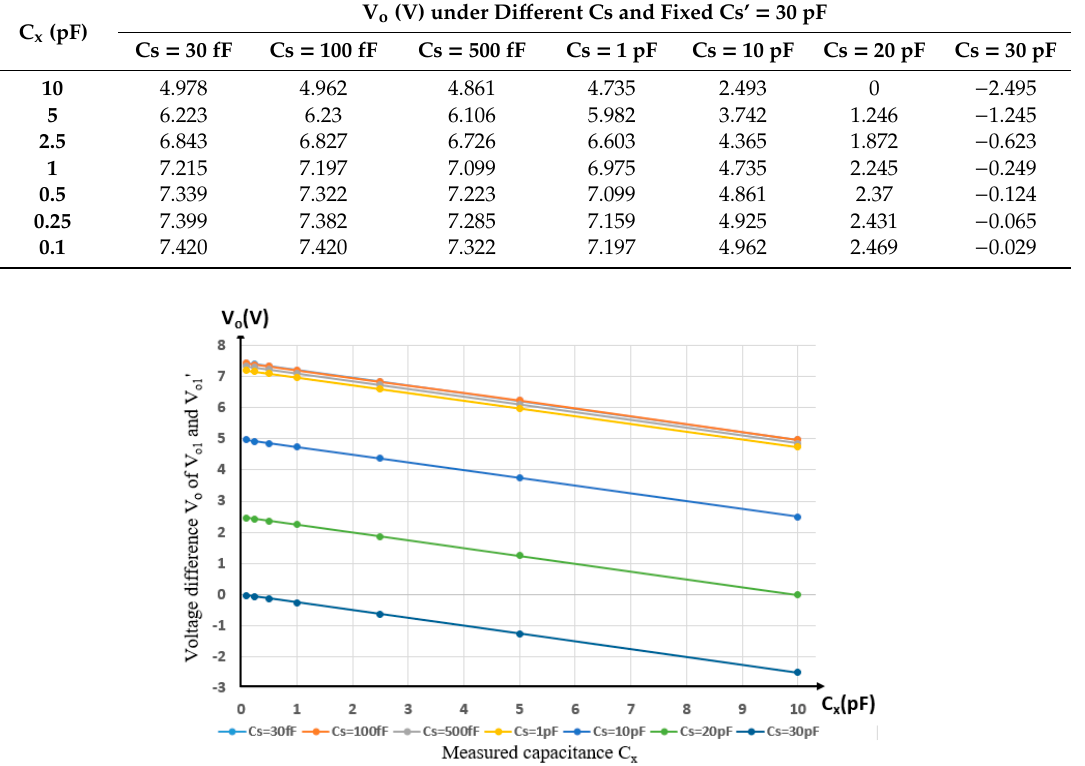
Figure 15. The output V o under di ff erent C x and C s